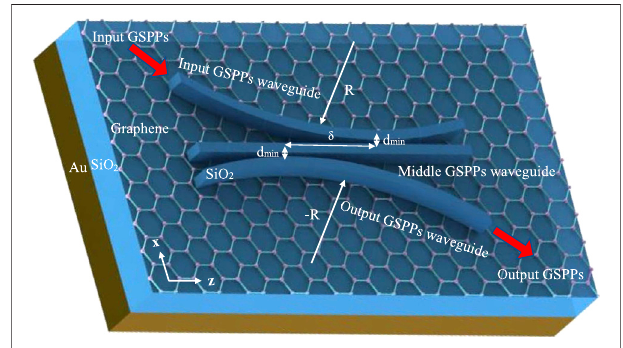
FIGURE 1 | Schematic representation of the dielectric-loaded graphene plasmon waveguide coupler based on STIRAP. The d min is the minimum distance between the input/output GSPP waveguide. The input and output waveguides are slightly curved, the radius of curvature is R , and the directions are opposite. In contrast, these waveguides are asymmetric, with a lateral mismatch δ between the two